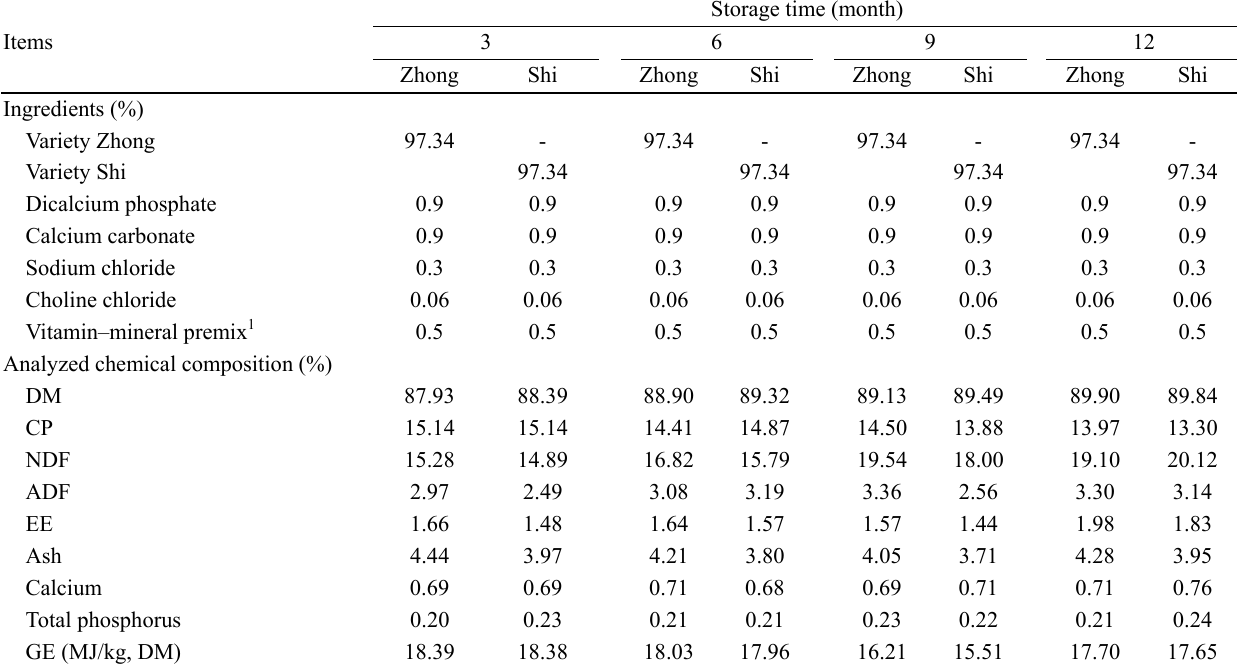
Table 2. Dietary ingredients, analyzed chemical composition and available energy content of the experimental diets (as-fed basis) Items